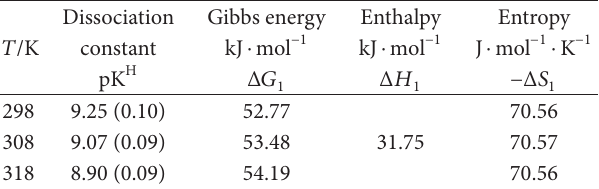
Standard deviations are given in parentheses. T 2: ermodynamic functions for the dissociation of